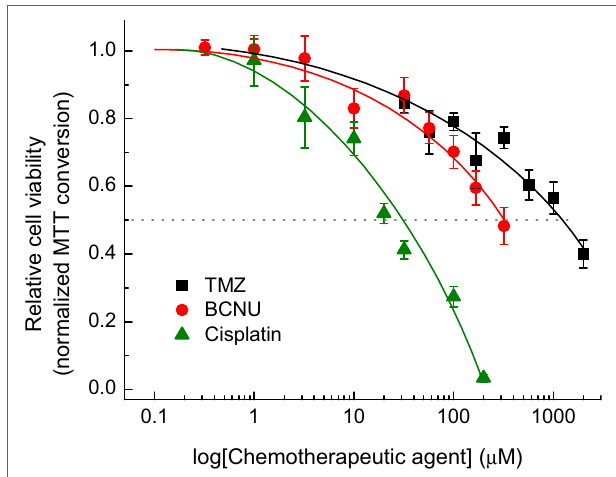
FigUre 2 | Dose-dependent effects of the chemotherapeutic agents temozolomide (TMZ), carmustine [bis-chloroethylnitrosourea (BCNU)], and cisplatin on viability of primary glioblastoma (GBM) cells. GBM cells were treated with various concentrations of chemotoxic agents and the relative cell numbers were compared 48 h later using a 3-(4,5-dimethylthiazol-2-yl)- 2,5-diphenyl tetrazolium bromide (MTT) assay. Each experimental point represents the mean values ± SE of four to eight independent measurements, which were accumulated in four independent experiments and normalized to an average MTT signal in non-treated cells within the same experiment. The three lowest concentrations of BCNU were tested two times.